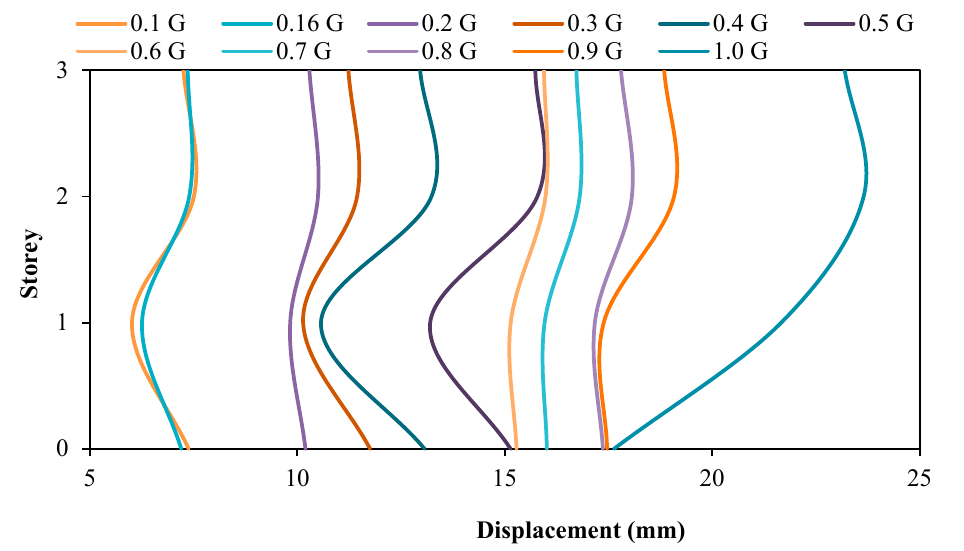
Figure 9. Storey drift of structure without dampers.